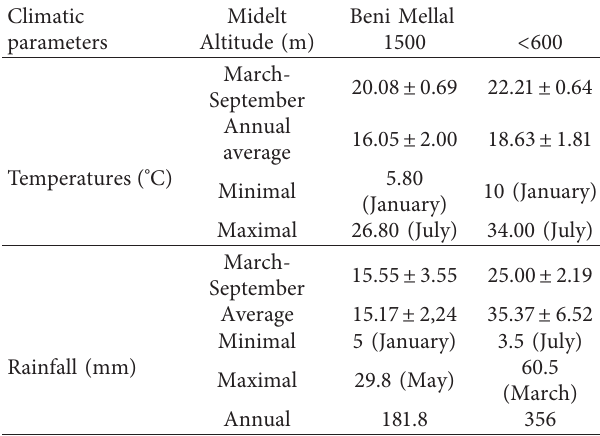
Table 1: Main climatic characteristics in prospected sites, average temperatures, and rainfall, calculated from monthly means of the four study